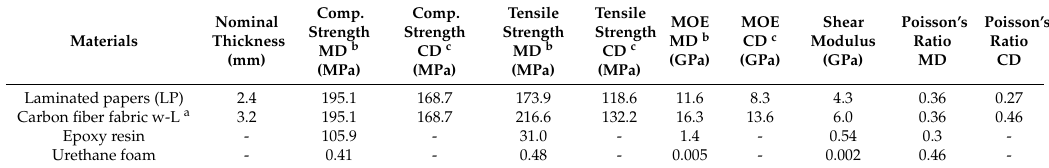
Table 1. Materials properties for individual structural panel components.